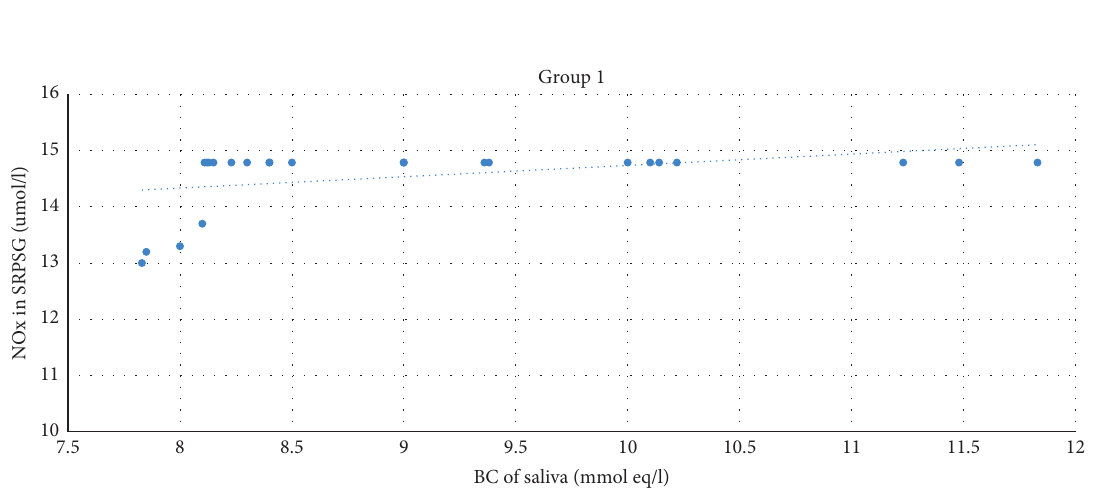
Figure 8: The correlation between the NOx level in SRPSG and the buffer capacity of saliva among patients in Group 1.